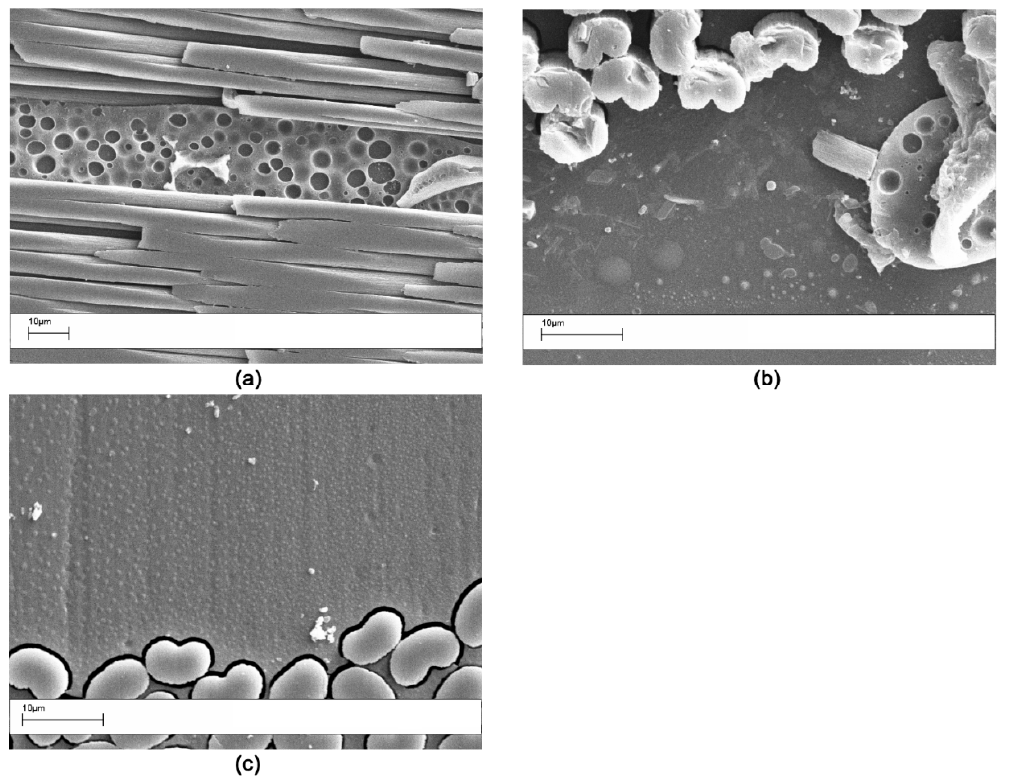
Figure 2. SEM morphology of the interlaminar region for the laminates modified with the soluble Virantage veils: ( a ) V1 (1000 × ); ( b ) V1 (2000 × ); ( c ) V2 (2000 × ).